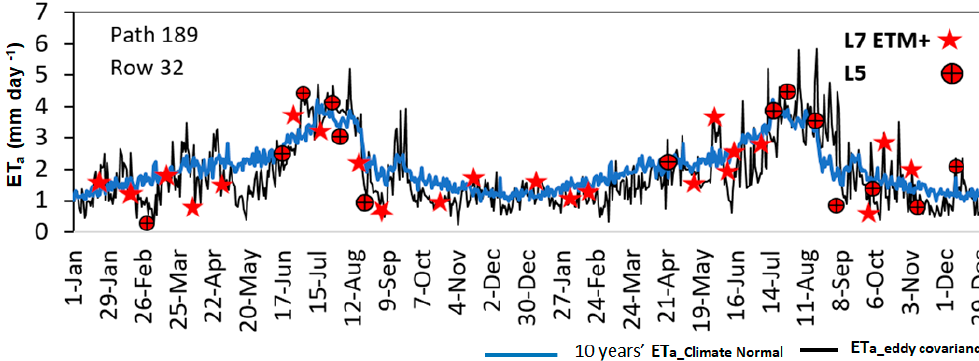
Figure 5. Measured weekly ET during the entire study period (2008–2009) and days corresponding to available Landsat image acquisition dates, along with ET a based climate normal (2004–2014) in the blue line. Red symbols marked temporal location of Landsat images with satellite types (Landsat 5 and Landsat 7 ETM+).